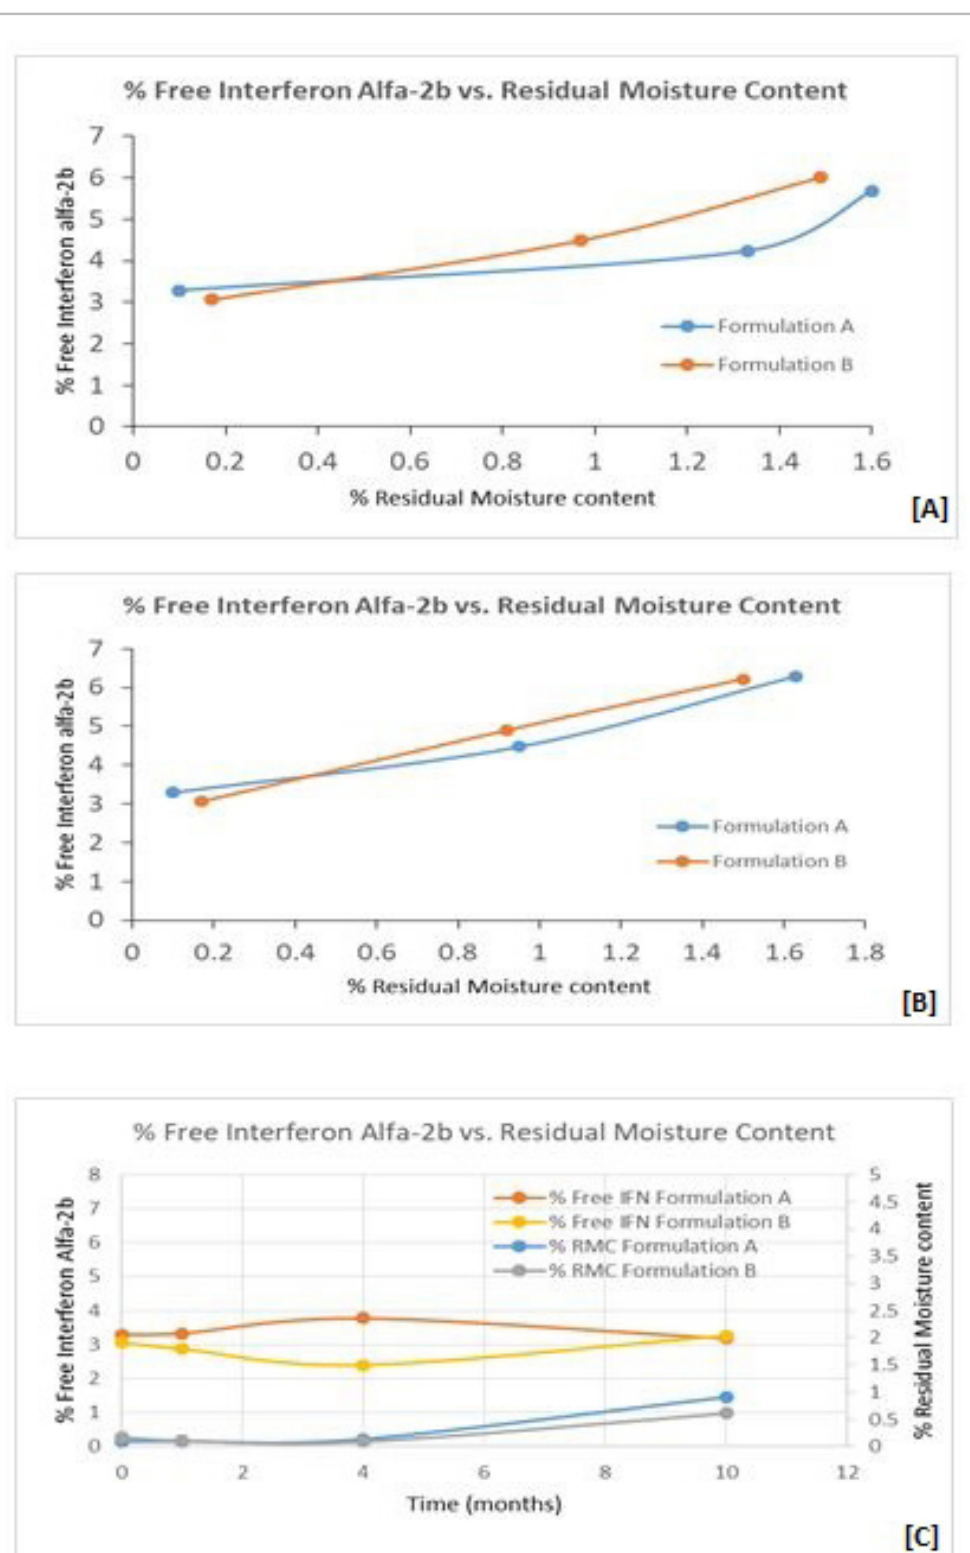
FIGURE 2 - Increase in free interferon alfa-2b (% Free IFN) with respect to increase in residual moisture content over the period of time: A) Formulation A and B exposed to stressed storage conditions (40 °C ± 2 °C; 75 % RH ± 5 % RH) B) Formulation A and B exposed to accelerated storage conditions (25 °C ± 2 °C; 60 % RH ± 5 % RH) C) Formulation A and B stored under real-time condition (between +2 °C and +8